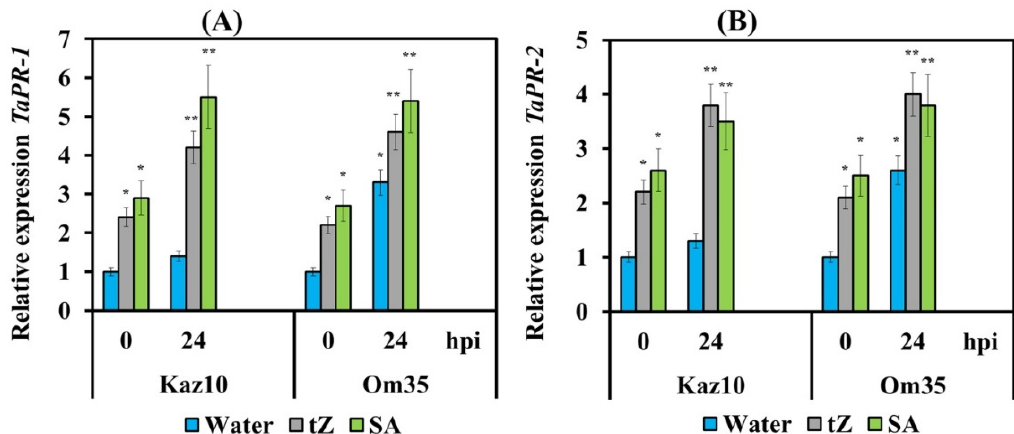
Figure 7. The effect of pretreatment with tZ and SA on the relative expression of salicylate signaling pathway marker genes TaPR-1 and TAPR-2 in Om35 and Kaz10 infected with SnB. ( A ) The mRNA abundance of the TaPR-1 gene. ( B ) TaPR-2 gene. Expression values are normalized to the housekeeping gene TaRLI as an internal reference and expressed relative to the normalized expression levels in mock-treated control (water) plants at 0 hpi. Symbols are the same as in Figure 5. Figures present means ± SE (n = 6). Asterisks indicate means statistically different from the control and different number of asterisks (*, **) allows distinguishing of significantly different variants according to the LSD test at * p < 0.05, ** p < 0.01.